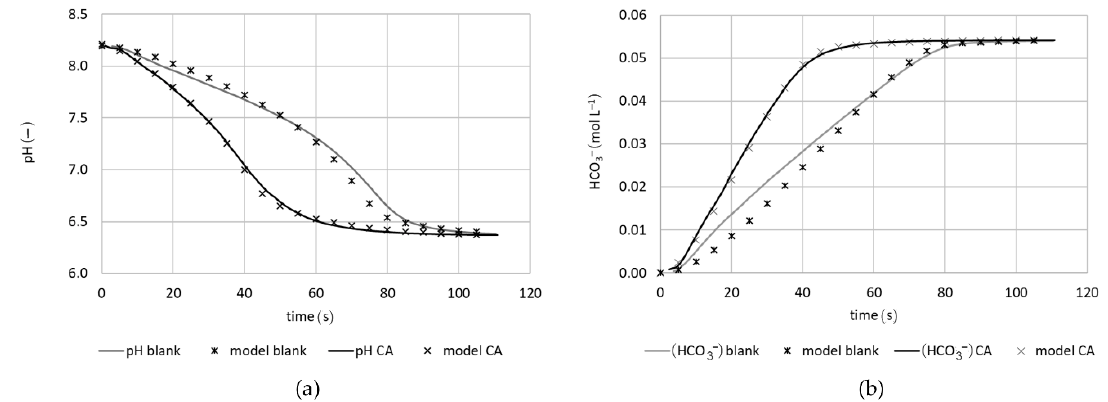
Figure 1. Overlay of measured and predicted values for the blank experiment and the standard enzyme (0.25 mg L − 1 ): ( a ) pH measured (solid line) versus model (x); ( b ) HCO 3 − concentration calculated from Equation (9) (solid line) versus model (x).